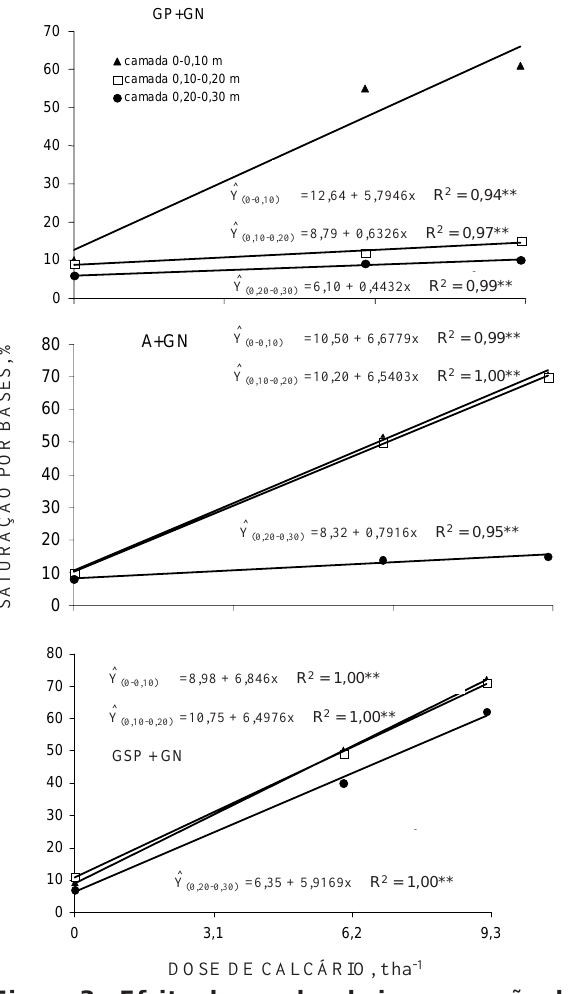
Figura 3. Efeito dos modos de incorporação do calcário por meio da gradagem pesada (GP + GN), aração (A + GN) e da gradagem superpesada (GSP + GN), considerando diferentes doses de corretivo e profundidades sobre a satu- ração por bases do solo (GN = grade